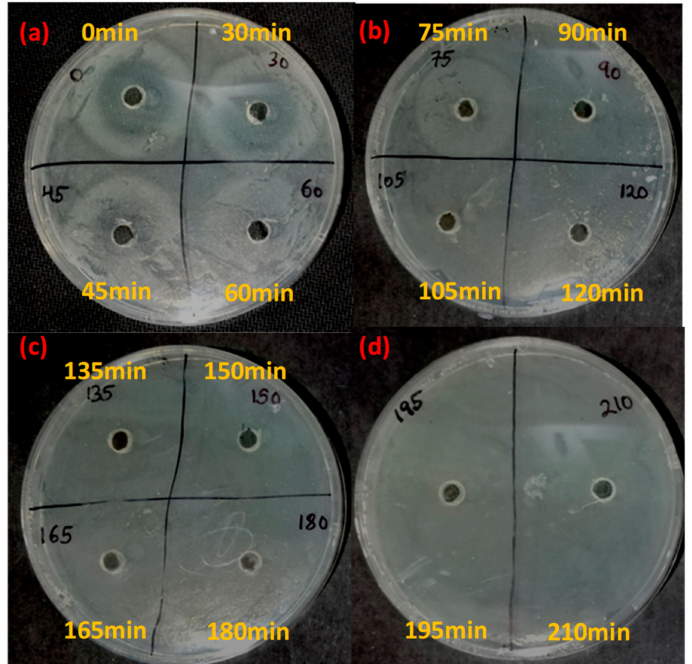
Figure 6. Residual antibiotic activity of the antibiotic ciprofloxacin after photocatalytic degradation with Fe-doped ZnO nanoparticles against Staphylococcus aureus . Yellow markings denote the time points at which sampling has been done. ( a ), ( b ), ( c ), ( d ) denotes the zone of inhibition shown by the antibiotic slurry collected at different time